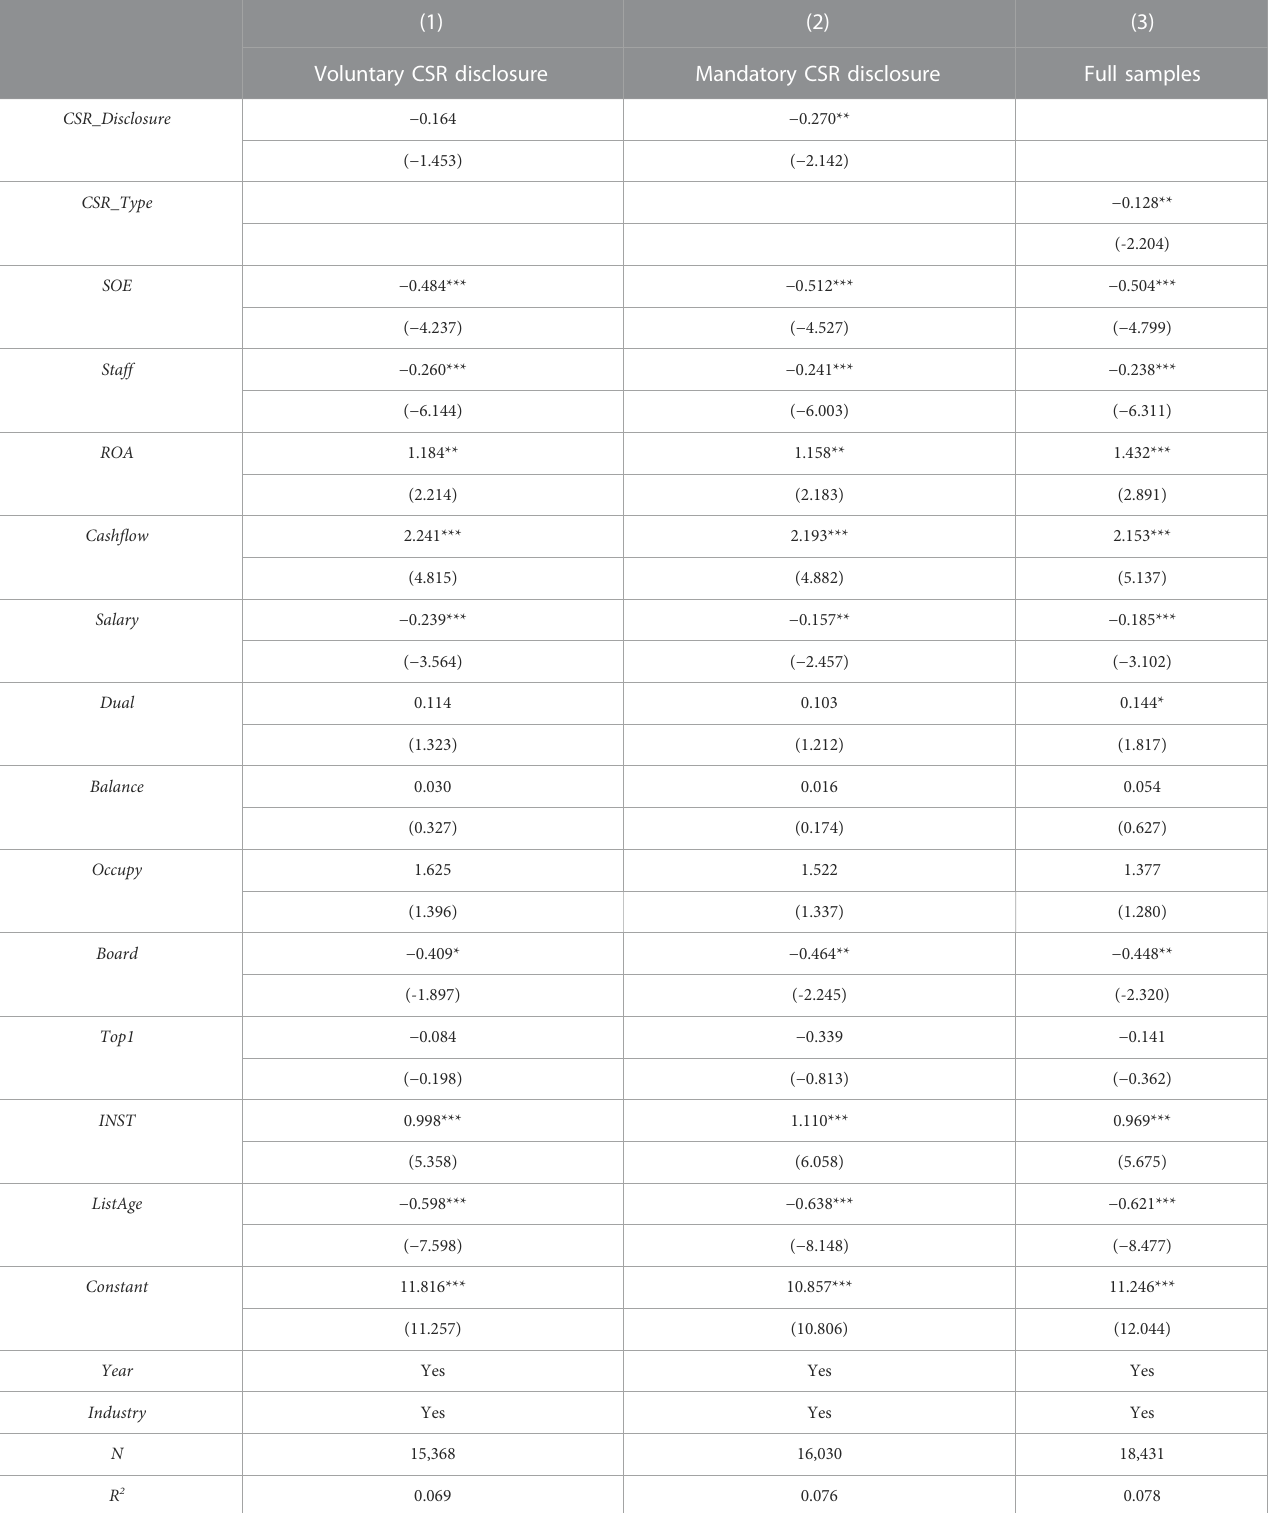
TABLE 7 Regression results about the mandatory vs. voluntary CSR